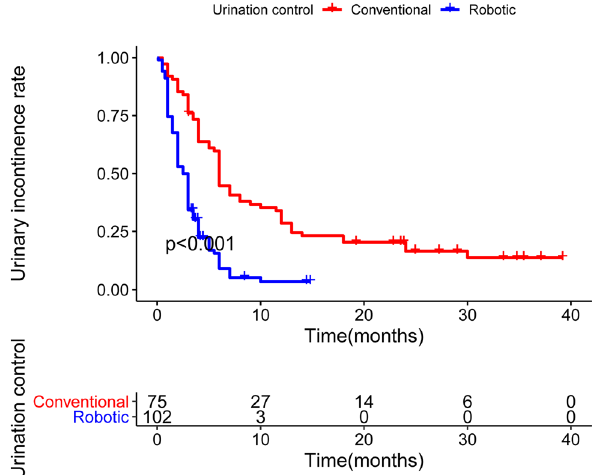
Figure 3. Difference in urinary incontinence recovery after operations with the two surgery approaches estimated with KM curves. According to the Kaplan–Meier methodology and compared using log-rank